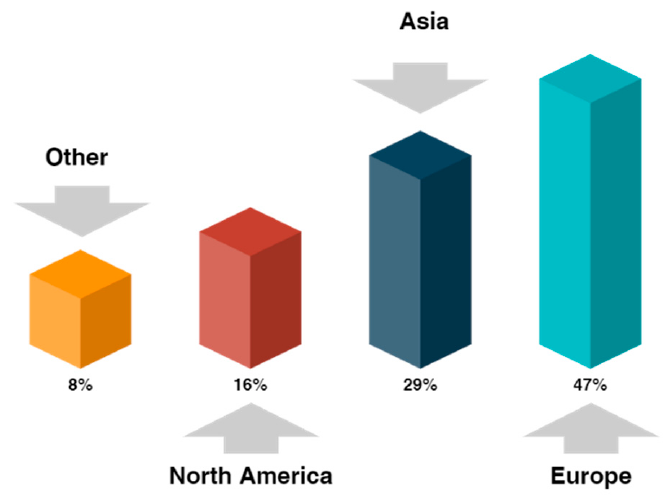
Figure 2. Percentage of studies per continent.